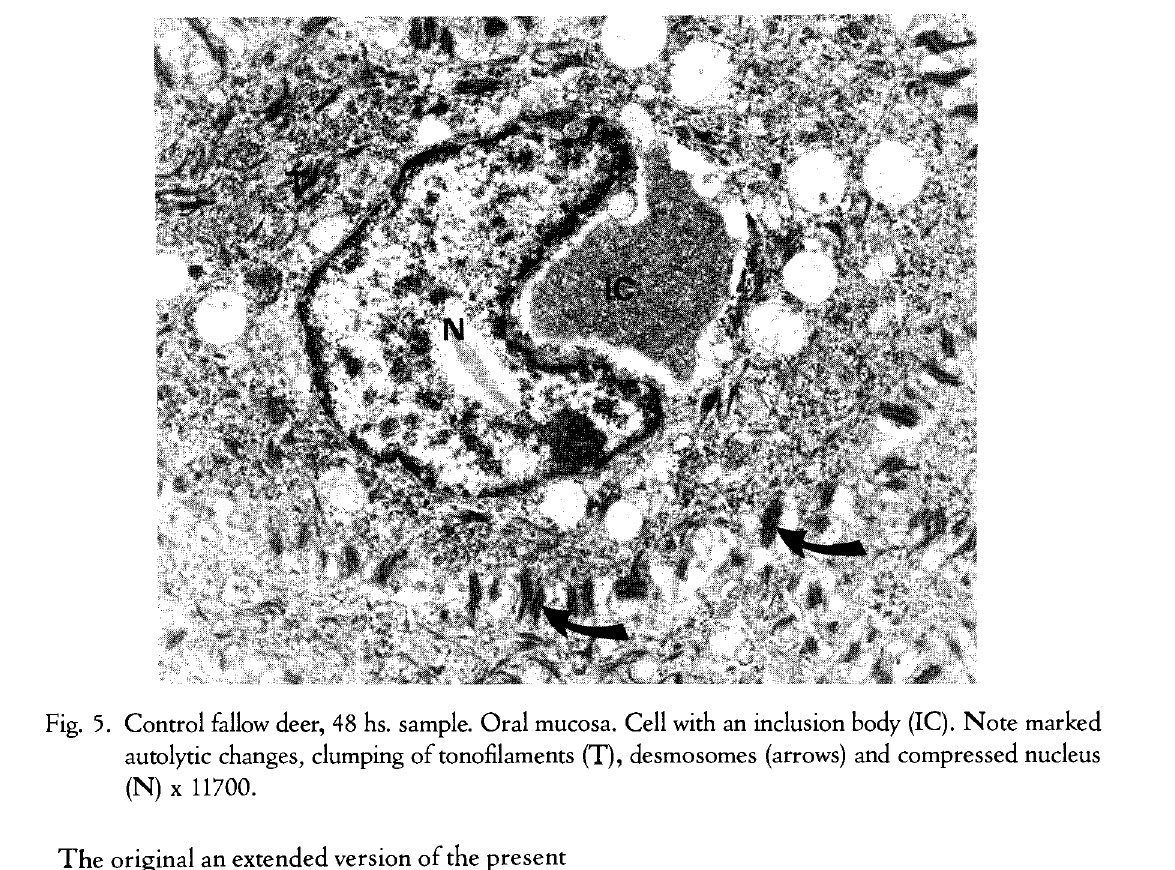
Fig. 5. Control fallow deer, 48 hs. sample. Oral mucosa. Cell with an inclusion body (IC). Note marked autolytic changes, clumping of tonofilaments (T), desmosomes (arrows) and compressed nucleus (N) x